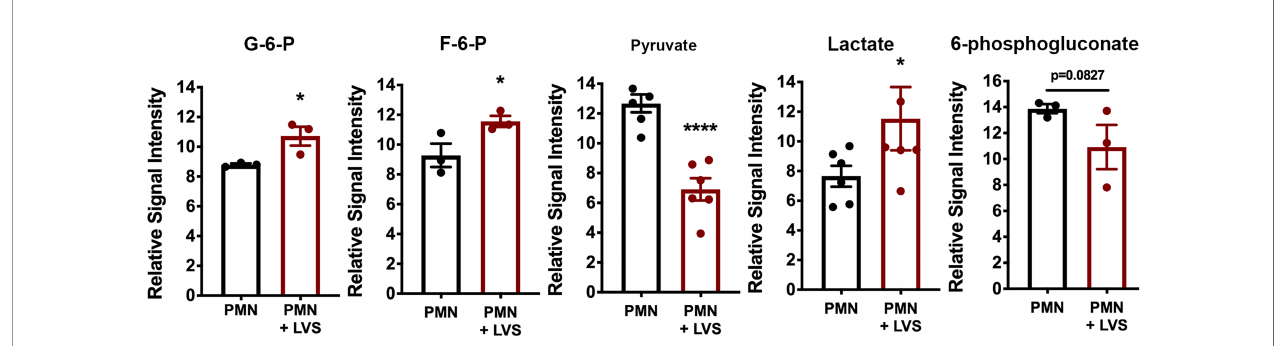
FIGURE 4 | Differential effects of LVS infection on PMN metabolite levels. The signal intensities of glucose-6-phosphate (G-6-P), fructose-6-phosphate (F-6-P), pyruvate, lactate and 6-phosphogluconate, relative to total ion signal, measured by GC-MS in control and LVS-infected PMNs at 9 hpi, n=3-6. * p < 0.05, **** p < 0.0001 as